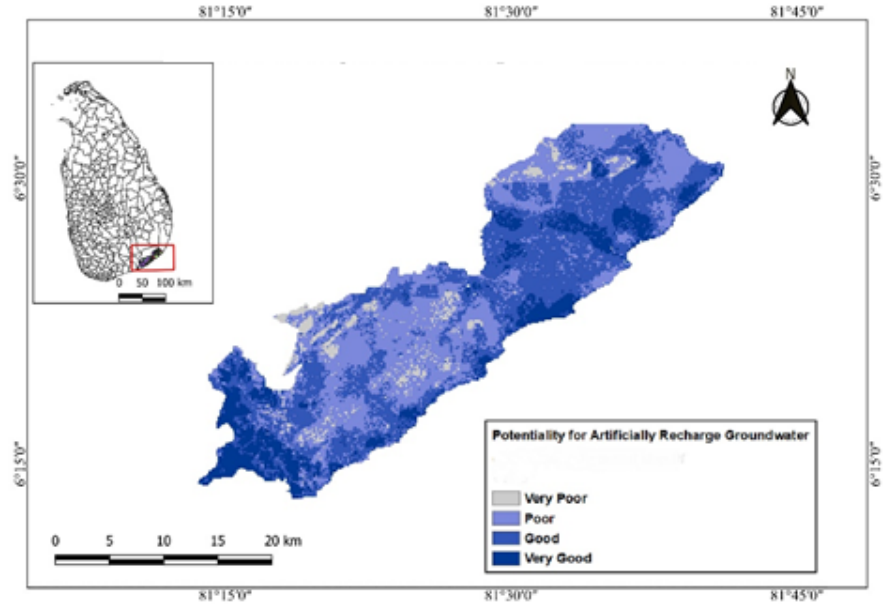
Figure 7. Artificial groundwater recharge potential zones in Tissamaharama DSD.